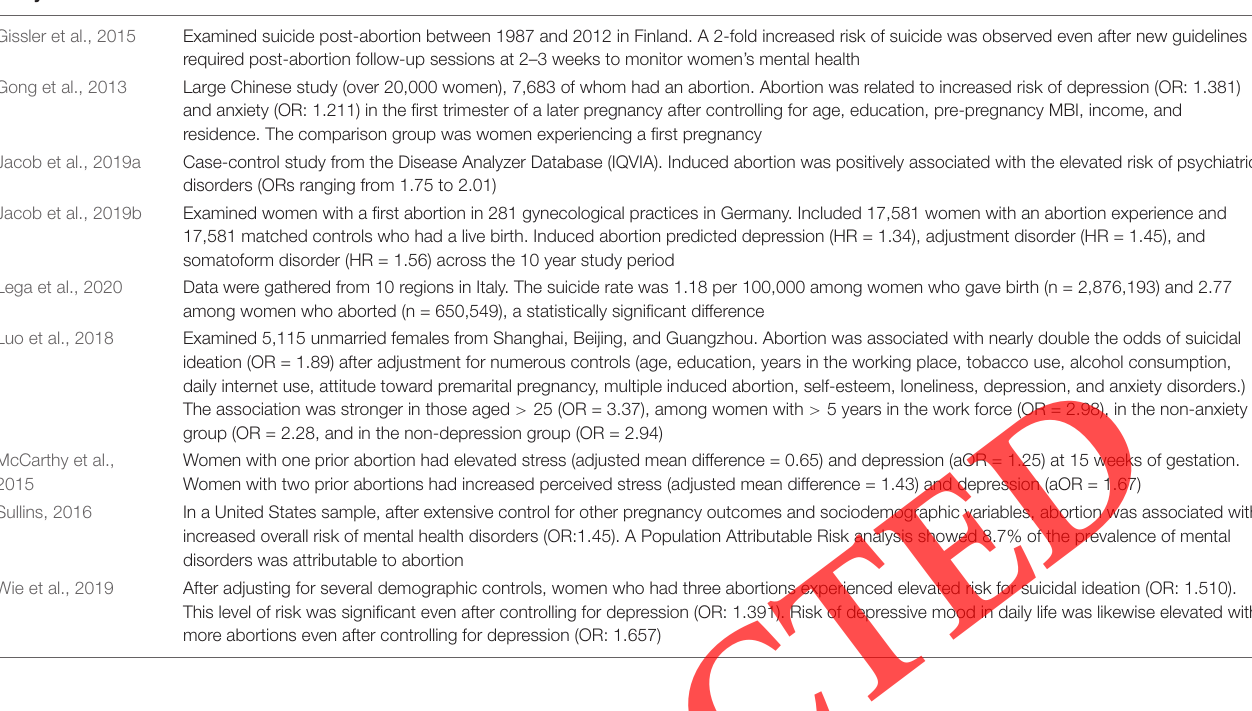
TABLE 1 | Recently published large scale research studies on the association between abortion and mental health. Study Results Gissler et al., 2015 Gong et al., 2013